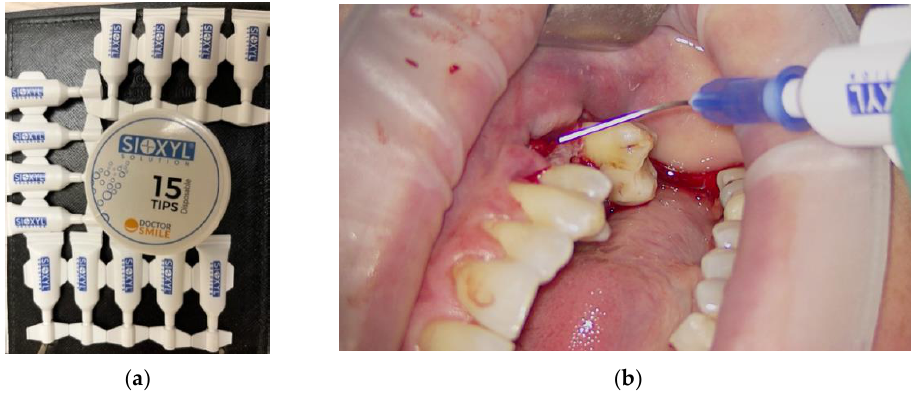
Figure 3. Sioxyl solution, solution based on hydrogen peroxide 10 volumes 3%, stabilized with glycerophosphates: samples ( a ); use in clinical practice ( b ).